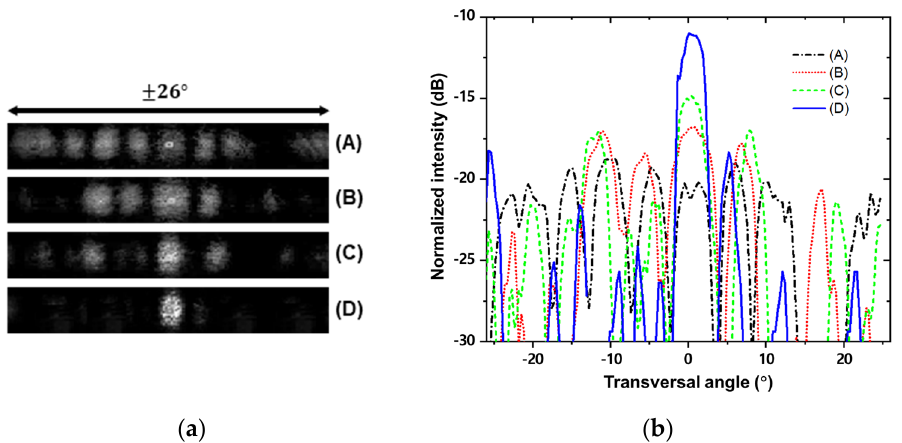
Figure 4. Experimental results of the process for forming a single beam using the phase shifters: ( a ) measured far-field patterns observed in a sequential process ( A )–( D ); ( b ) measured intensity distri- ( a ) measured far-field patterns observed in a sequential process (A)–(D); ( b ) measured intensity bution corresponding to the far-field patterns in ( a ). distribution corresponding to the far-field patterns in ( a